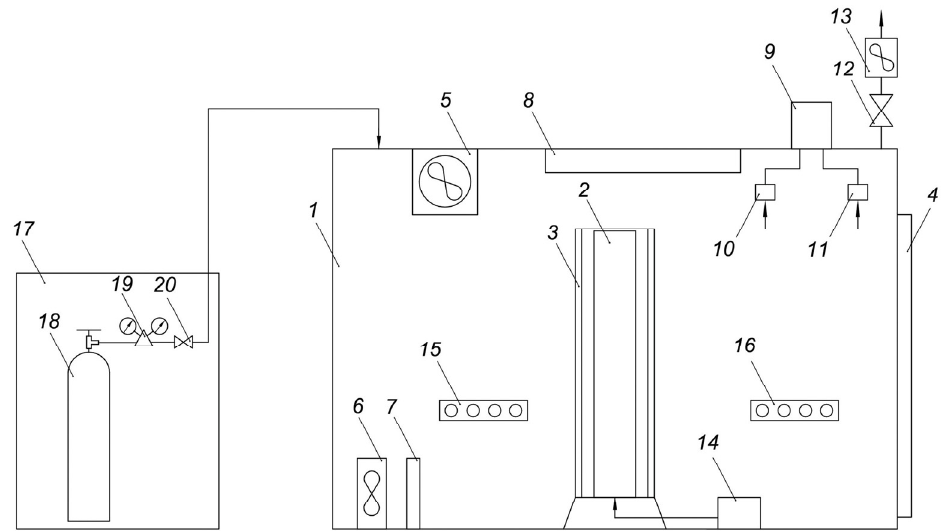
Figure 1. Schematic diagram of atmospheric gas chamber (AGC) used in experiments. 1—Chamber,